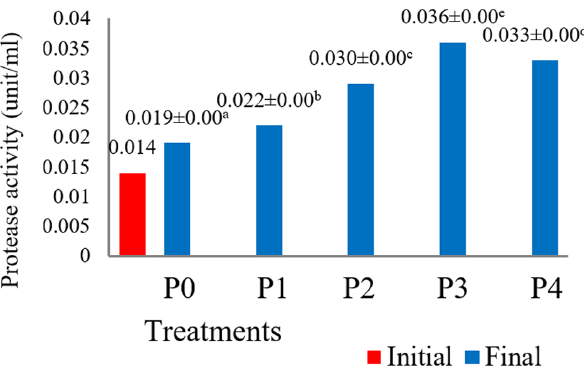
Figure 1. Changes in protease enzyme activity in the intestine of silver pompano. P0 = FFM 0%, P1 = FFM 10%, P2 = FFM 20%, P3 = FFM 30%, and P4 = FFM